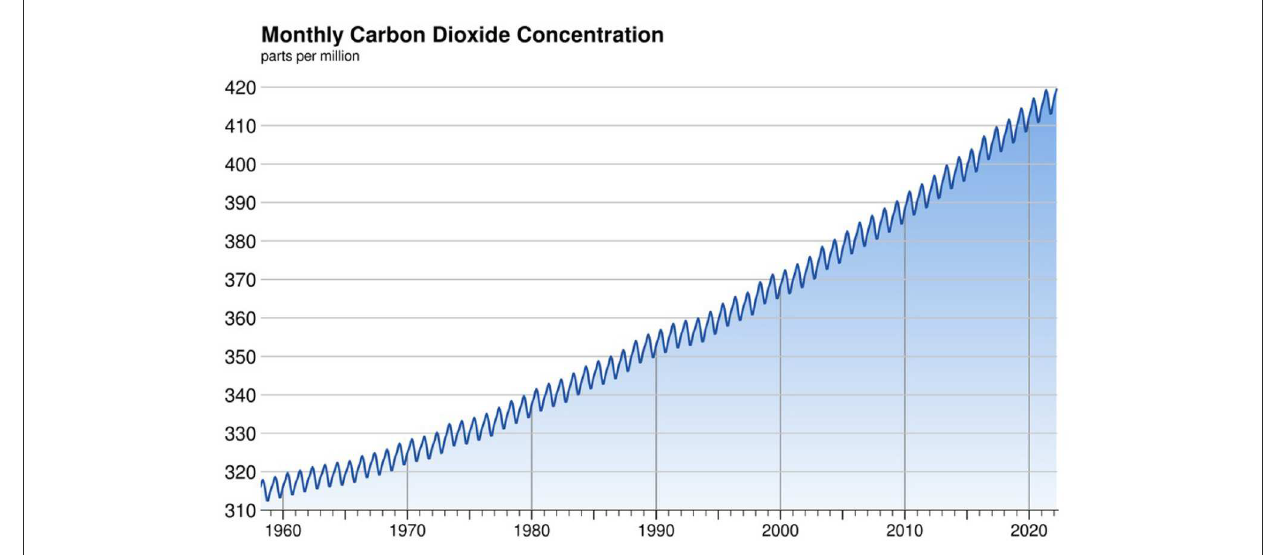
FIGURE1 CO 2 concentrations over the past 60 years. Available online at: https://scrippsco2.ucsd.edu/graphics_gallery/mauna_loa_record/mauna_loa_ record_color.html . Graph is in the public domain and free to use (accessed May 07,